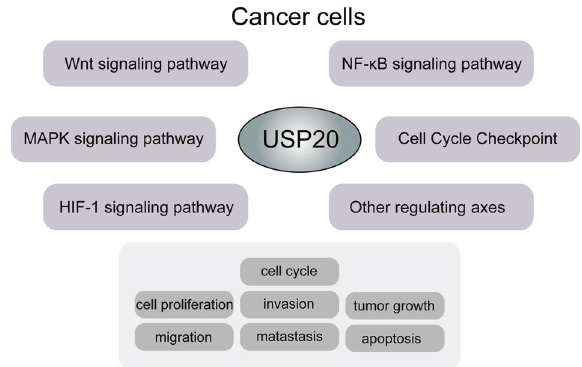
Fig. 3 The mechanism of deubiquitinating enzyme USP20 in cancer. USP20 regulates cell proliferation, migration, invasion, metastasis, and tumor growth by participating in multiple signaling pathways in various cancer